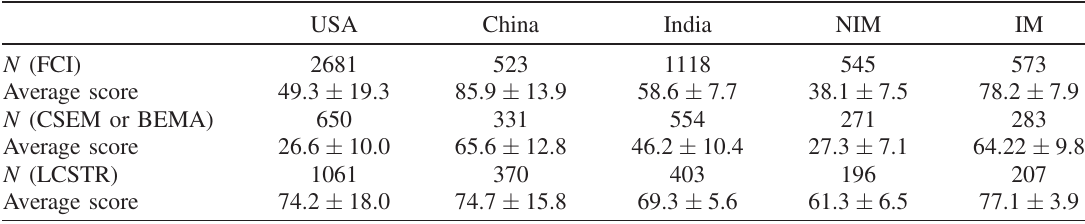
TABLE I. The sample size ( N ) and average scores in percentage of the U.S., Chinese, and Indian students along with the associated standard deviations, in the FCI, CSEM or BEMA, and LCSTR. For Indian students the data are first shown for the total sample, then separately for the NIM and the IM. Source of the data for the U.S. and China is the study by Bao et al. [1]. Note that for the U.S. and Chinese samples, BEMA was used instead of